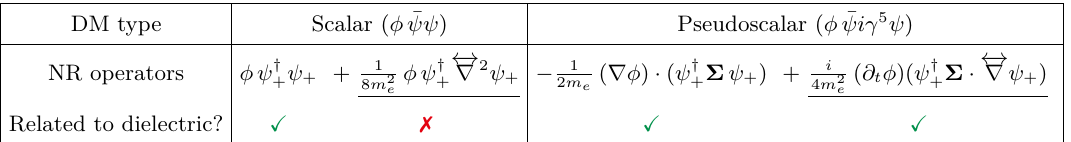
Table 1 . Summary of results for scalar and pseudoscalar DM φ coupling to electron ψ . The effective operators at LO and NLO in the NR ( 1 /m ) expansion are shown in the second row. In e both cases, the NLO operator (underlined) gives the dominant contribution to DM absorption. Importantly, the dominant contribution in the scalar case is not directly related to the target material’s conductivity/dielectric function. See sections 2 and 3 for